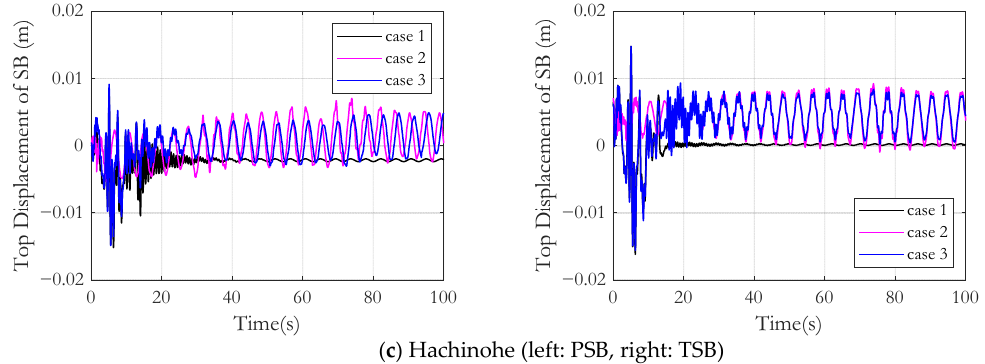
22 of 25 Figure 21. Top displacement of SB under joint action of seismic–wind combination and scour con ‐ dition.